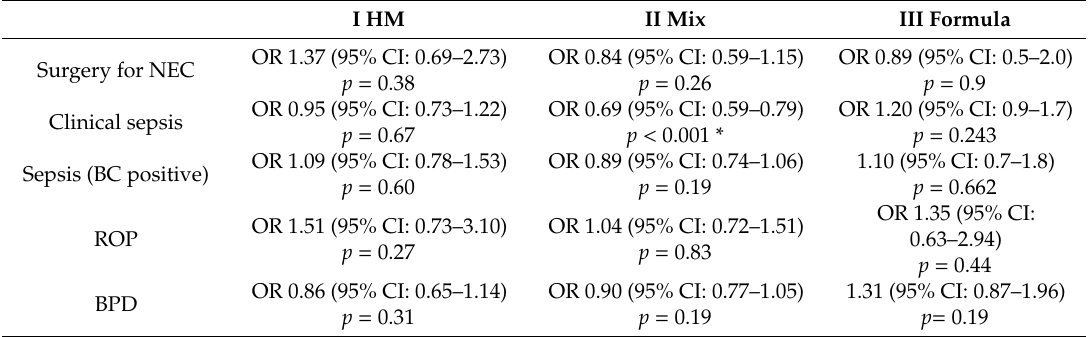
Table 1. E ff ect of probiotic treatment on short-term outcomes in the context of feeding types. I HM II Mix III